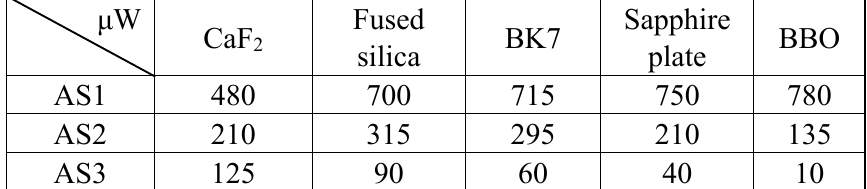
Table 1. The output power of different sidebands for several different bulk media when the external crossing angle is about 1.8º. In the case, the input power of beam1 and beam2 are 7 mW and 25 mW, respectively